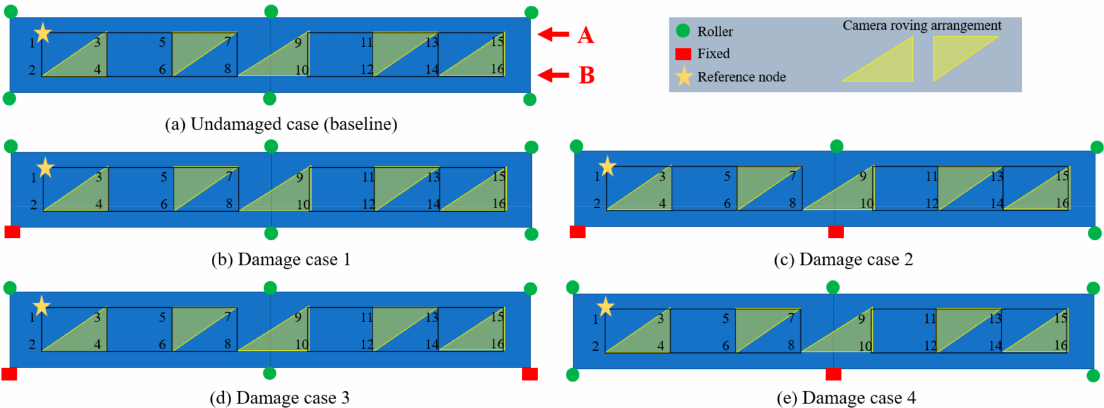
Figure 4. Experimental cases and